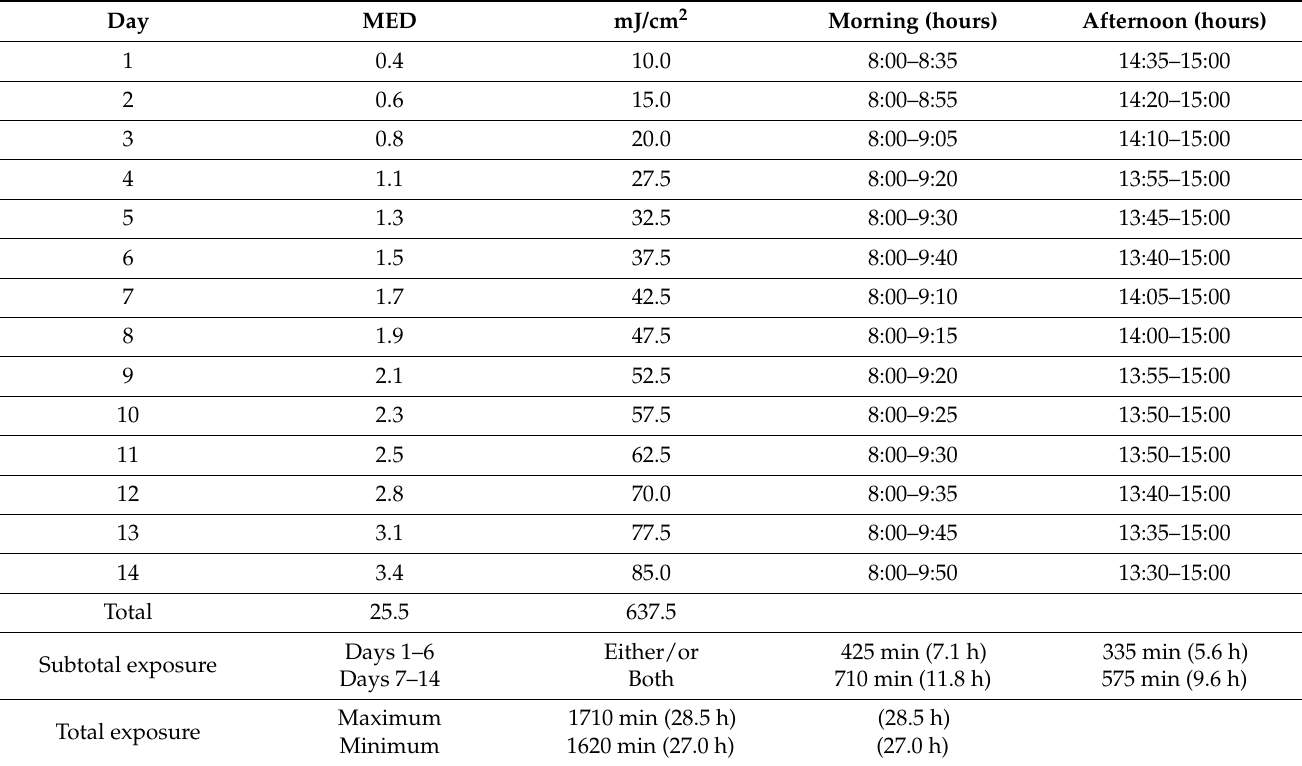
Table 7. Recommended sun-exposure protocol for skin type 2 for the month of March for a